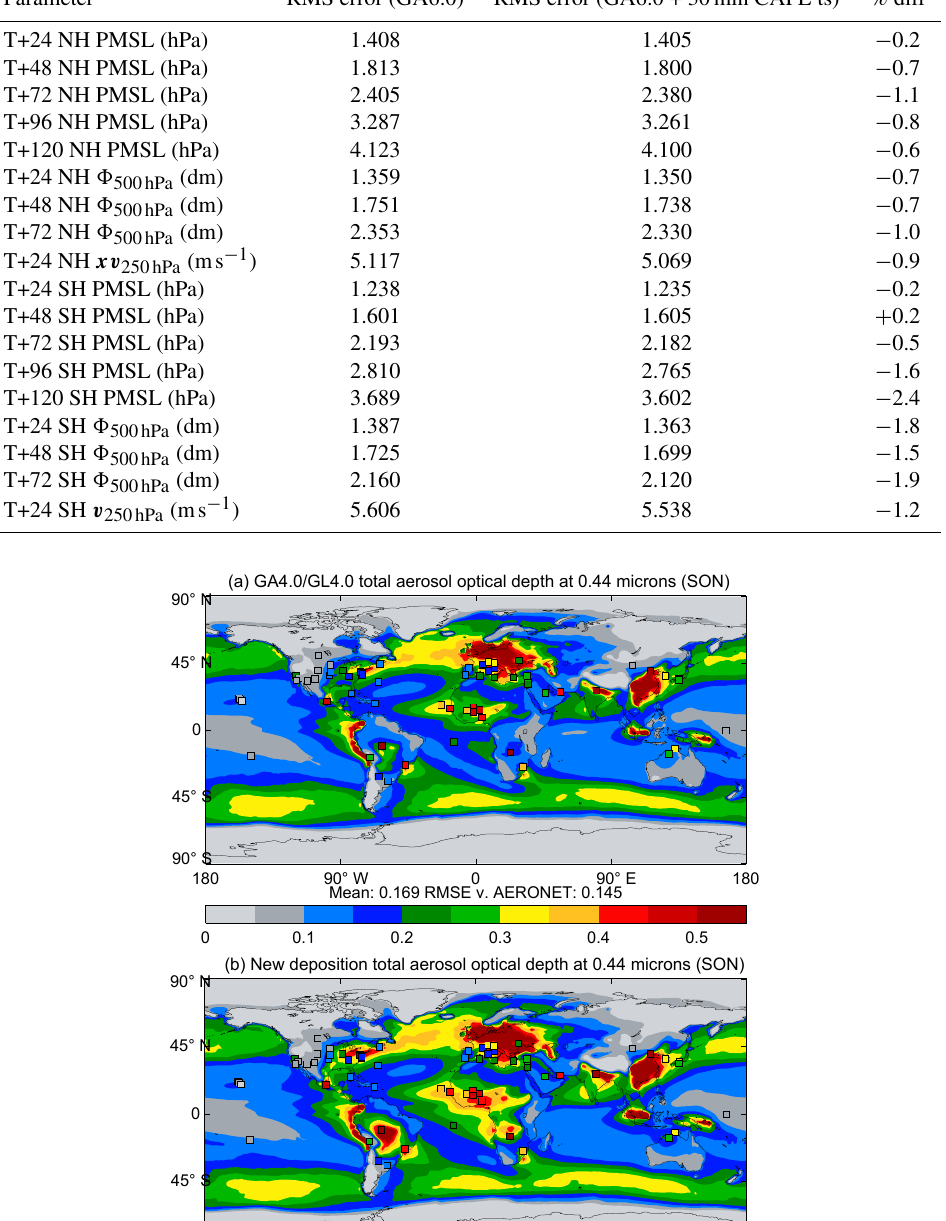
Table 3. The difference in root mean square error vs. observations in a number of extra-tropical performance measures due to reducing the CAPE timescale from 1h to 30min in a set of 24 N320-resolution forecast case studies run from operational ECMWF analyses. The parameters are pressure at mean sea level vs. synoptic observations (PMSL) and geopotential heights and vector wind errors vs. radiosondes at 500 and 250hPa respectively ( (cid:56) 500hPa , v 250hPa ). Parameter RMS error (GA6.0)